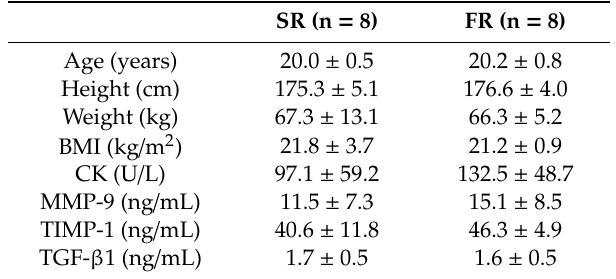
Table 1. Subject characteristics and baseline measurements (n = 16, mean ±